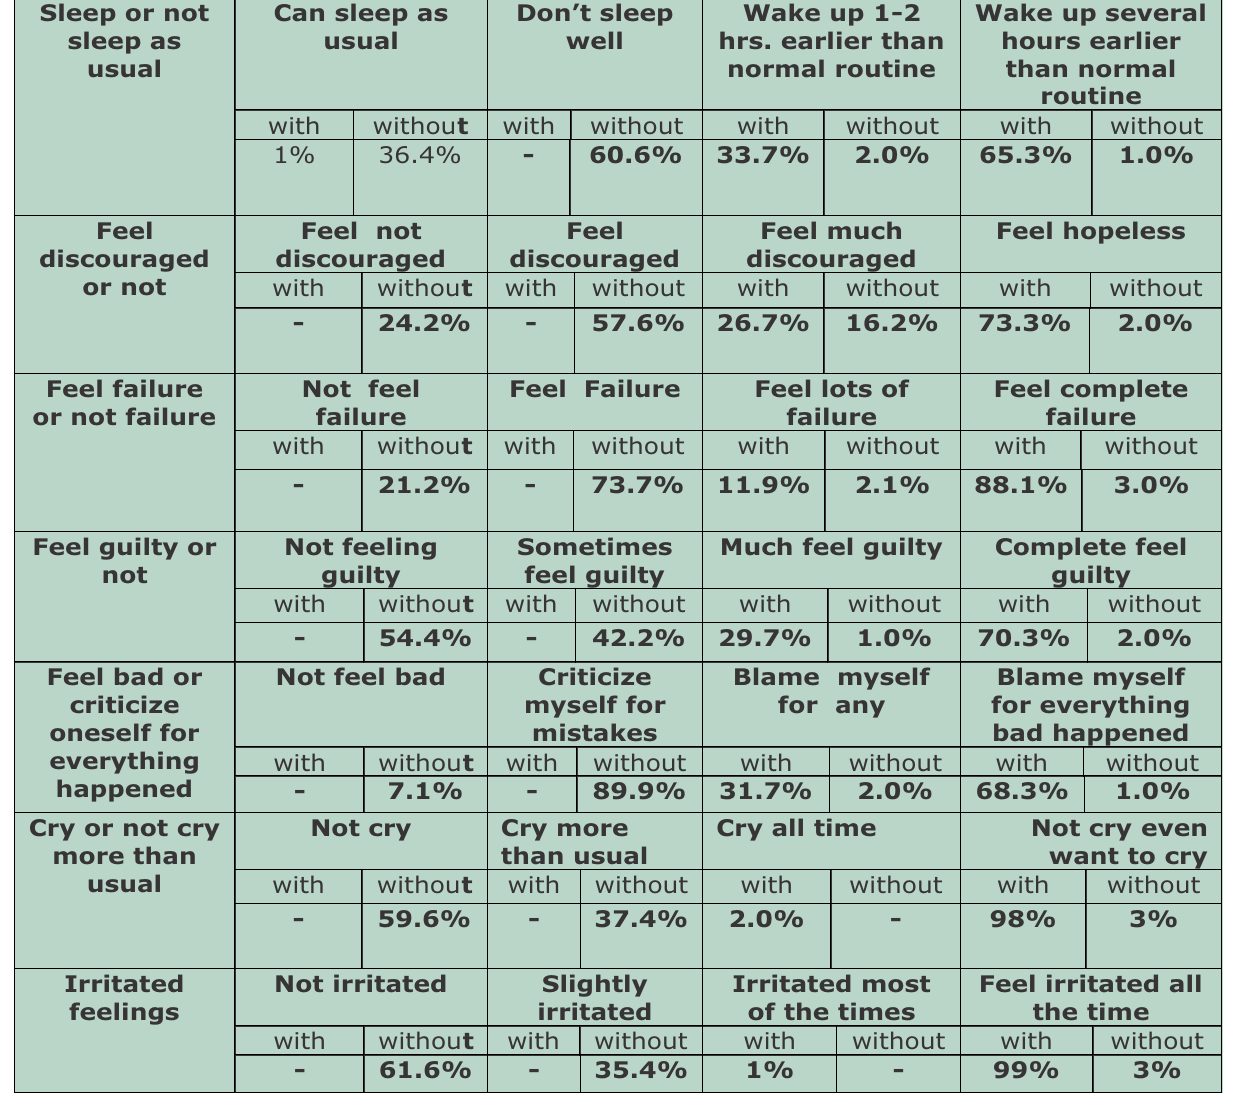
Table-II: Comparison of depression among women with and without miscarriages (using Beck's